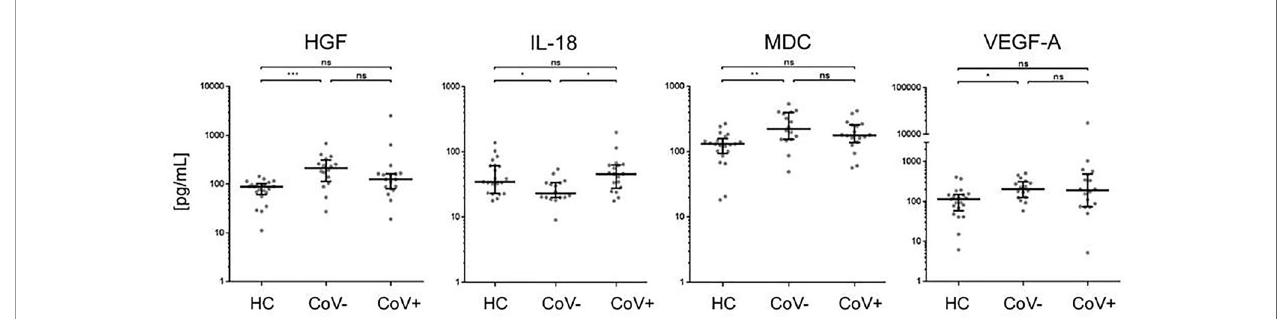
FIGURE 2 | Serum markers elevated or downregulated markers in COVID-19- patients compared to healthy controls and COVID-19+ patients. The indicated in fl ammatory markers were assessed by multiplex analysis from the serum of healthy control (HC) volunteers, symptomatic, COVID-19 negative tested patients (CoV-) and symptomatic, COVID-19 positive tested patients (CoV+). For each marker, individual results are depicted as dot plots. Each point represents the median of two technical replicates of each individual. Data are shown on a logarithmic scale for better visualization. Data are shown as median and interquartile range 25%-75%. p > 0.05 = ns not signi fi cant; *p < 0.05, **p < 0.01, ***p < 0.001, Group differences between the three cohorts were tested using Kruskal-Wallis-test in conjunction with Dunn ’ s multiple comparisons test using multiplicity adjusted calculation of p-values. (HC, n=21), (CoV-, n=16), (CoV+, n=18). (HC, n=21)); HGF, hepatocyte growth